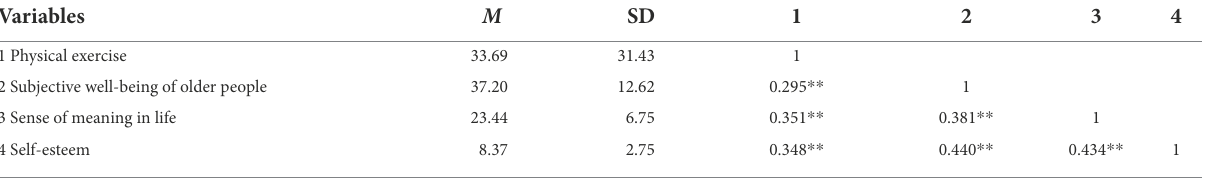
TABLE 2 Correlation analysis of physical exercise, subjective well-being, sense of meaning in life and self-esteem in older people ( N = 419).